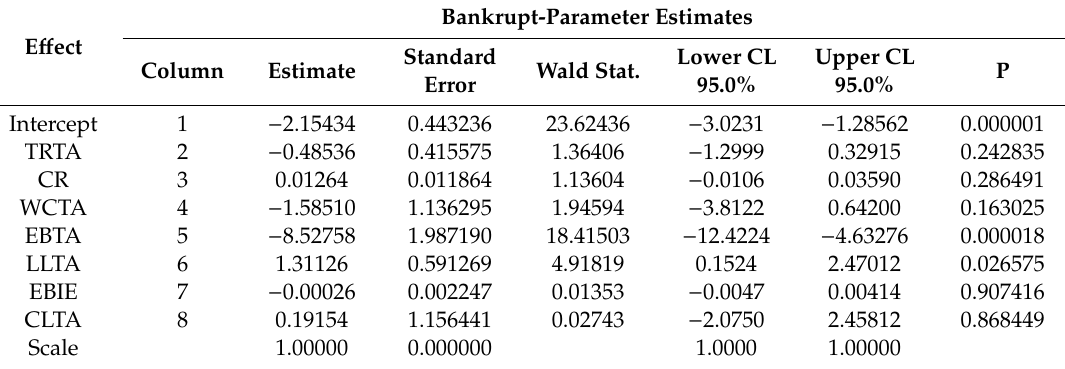
Table 5. Logit function coefficients.